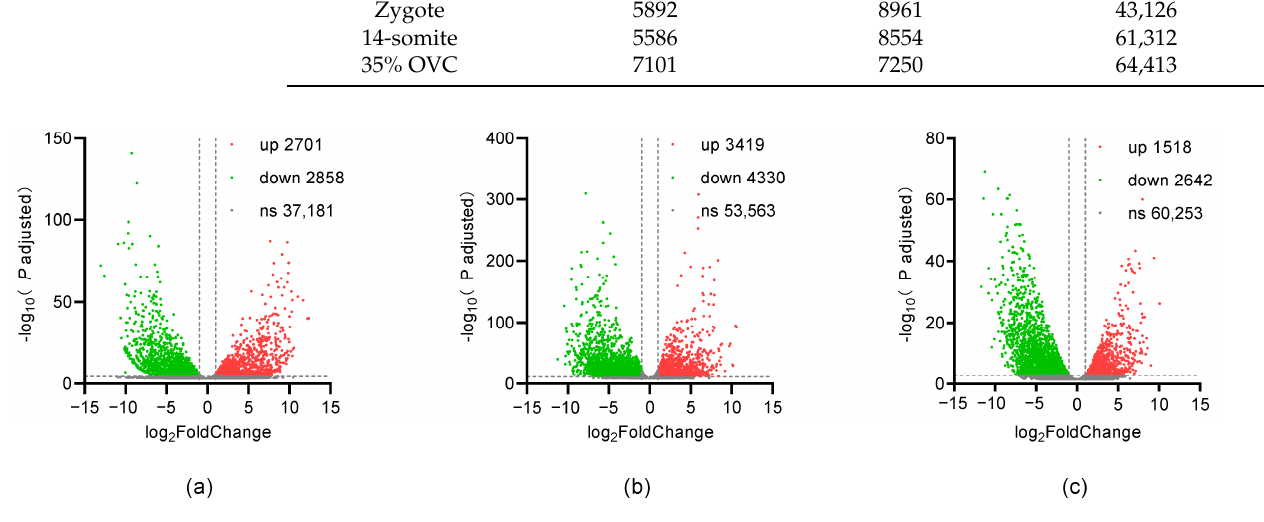
Figure 7. Differentially expressed genes between CE and RK goldfish at different embryonic stages.